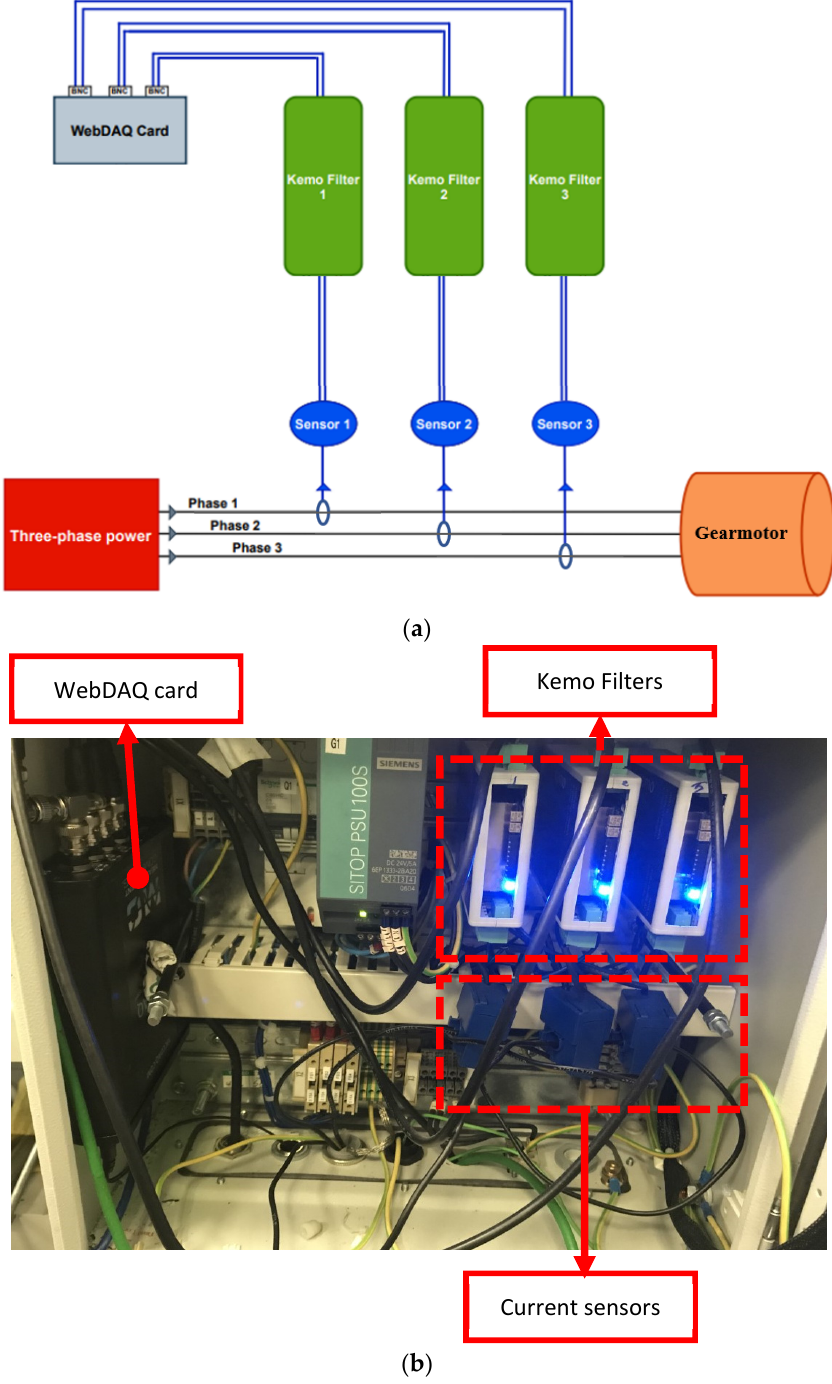
Figure 2. ( a ) schematic of the data acquisition system; and ( b ) the data acquisition system.